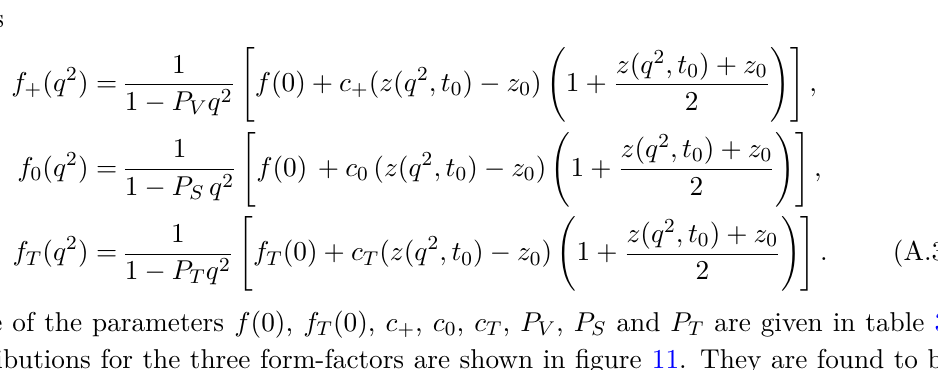
√ √ = ( m + m )( ) 2 . The parameterisation is m − m 0 π π D D